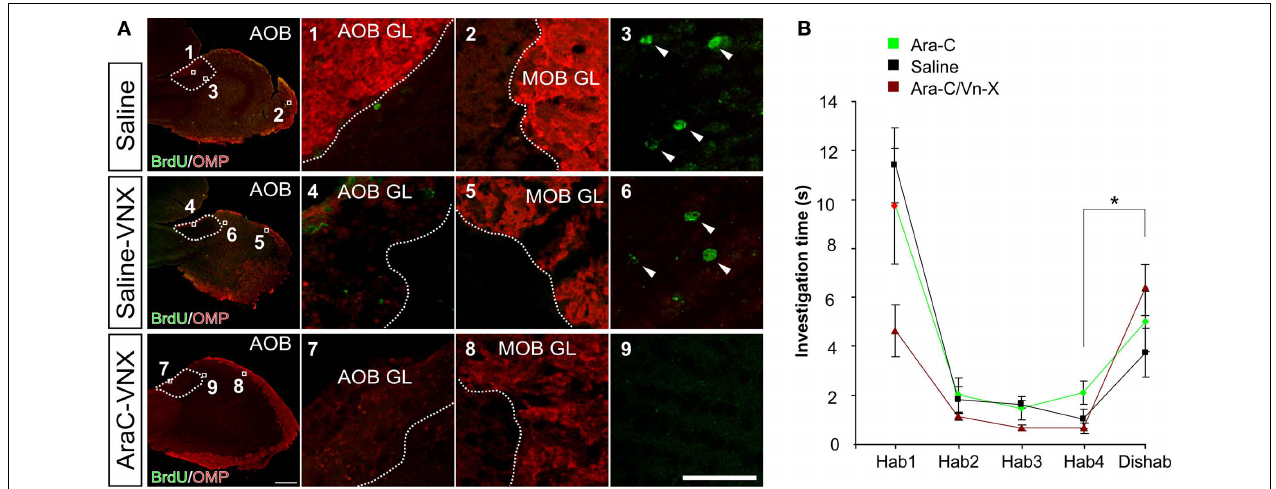
for image details. (B) Habituation/dishabituation task for male volatile odor discrimination in Saline/Ara-C treated mice. Odor sources consisted of filter paper stripes soaked with male urine derived from different individuals and contained in a plastic box to prevent direct nasal contact but not odor perception. Mice were habituated to an odor with four consecutive presentations. On the fifth presentation a different odor was presented. Both saline-treated and neurogenesis-ablated mice (normal orVNX) similarly increased the investigation time in response to the new odor. Means ± SEM, *P <